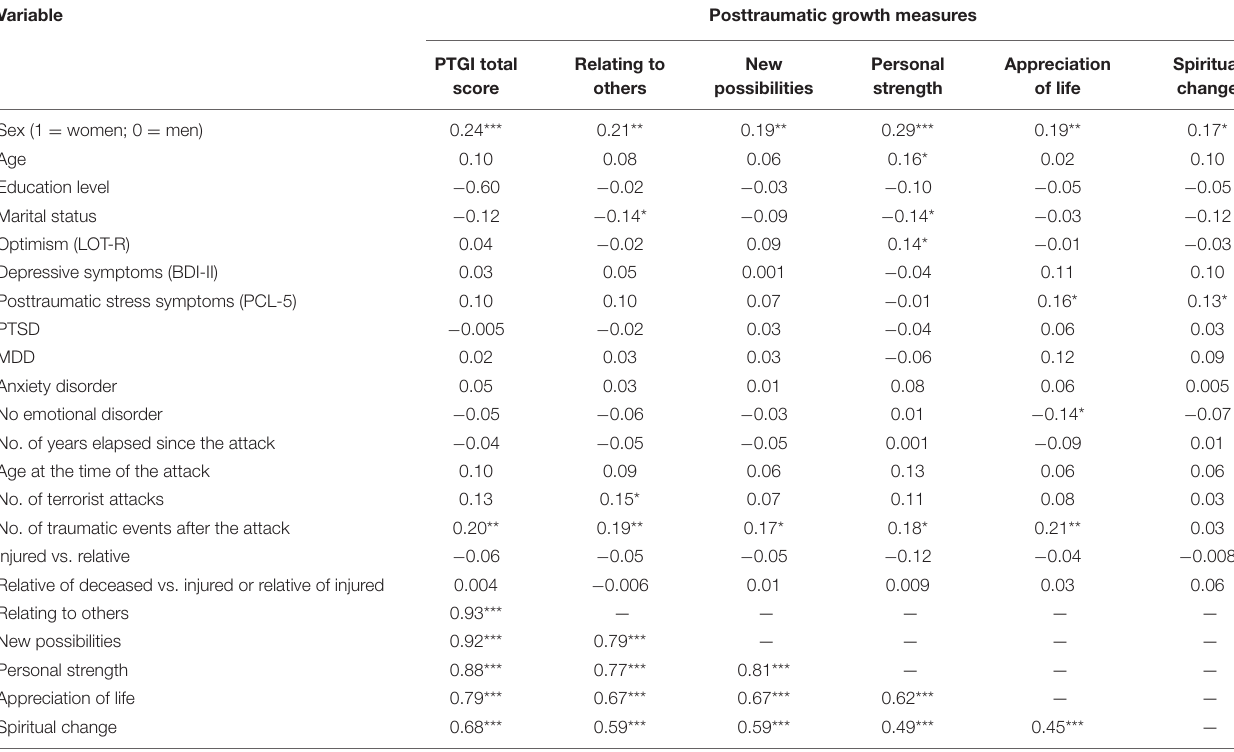
TABLE 3 | Correlations of the post-traumatic growth measures of the PTGI with the sociodemographic, clinical and attack-related variables. Variable Posttraumatic growth measures Relating to